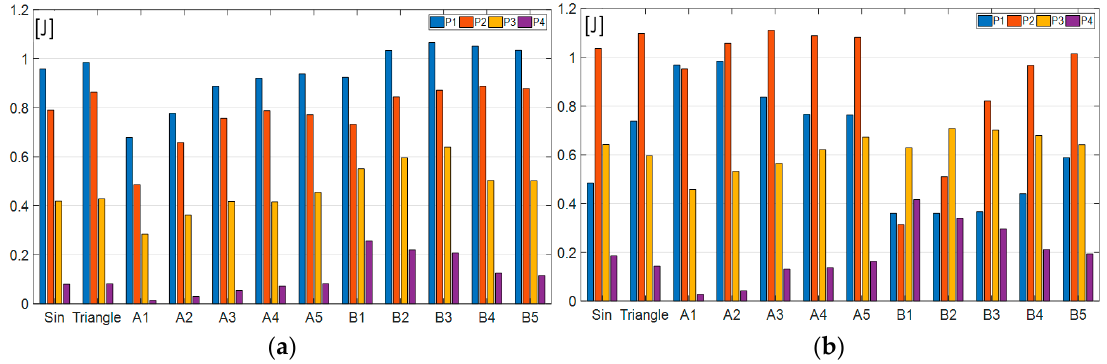
Figure 7. Average arc energy E a calculated for voltage waveforms for: ( a ) CI-1 ( b ) CI-2.